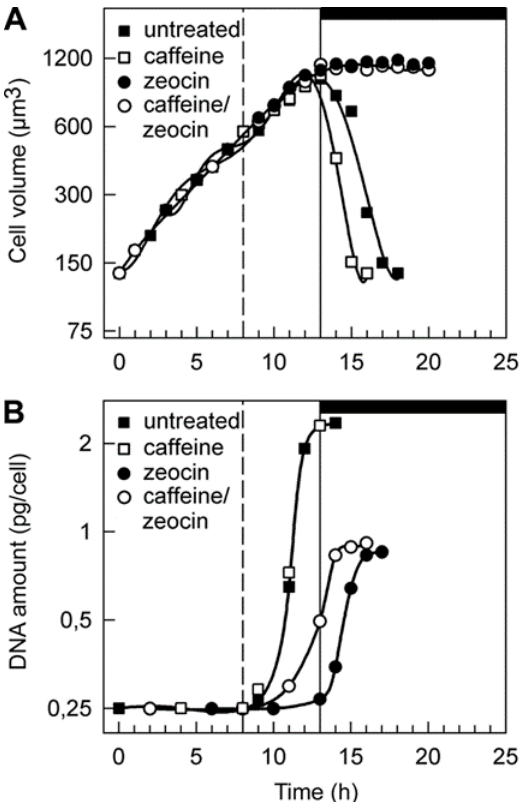
Figure 3. Cell growth and increase in DNA in synchronized populations of C. reinhardtii cells. The upper graph ( A ) depicts changes in size of cells grown in the absence of chemicals (full squares), or presence of caffeine (empty squares), zeocin (full circles) and caffeine/zeocin (empty circles). The bottom graph ( B ) shows the course of DNA replication in the absence of chemicals (full squares), or presence of caffeine (empty squares), zeocin (full circles) and caffeine/zeocin (empty circles). The time of addition of the chemicals is indicated by the dashed line, light and dark periods are marked by stripes above the panel and by the vertical solid line. Means from at least three independent experiments are presented; the standard error did not exceed 5%. Cell growth was not affected by the presence of the drugs, and DNA replication was delayed in the presence of zeocin and caffeine/zeocin.